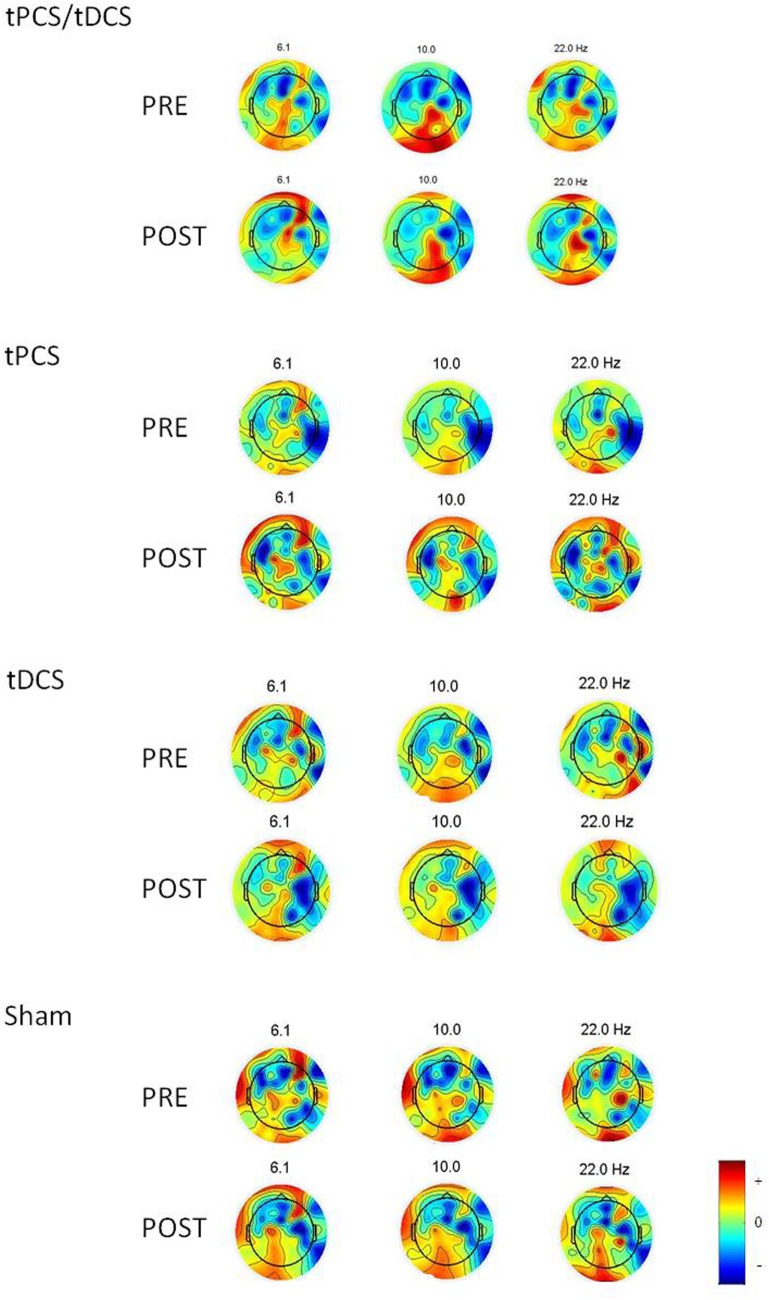
Topoplots showing the topographic distribution of the different bandwidths for a representative individual before and after each intervention. Red areas represent higher activity, while blue areas represent lower activity.